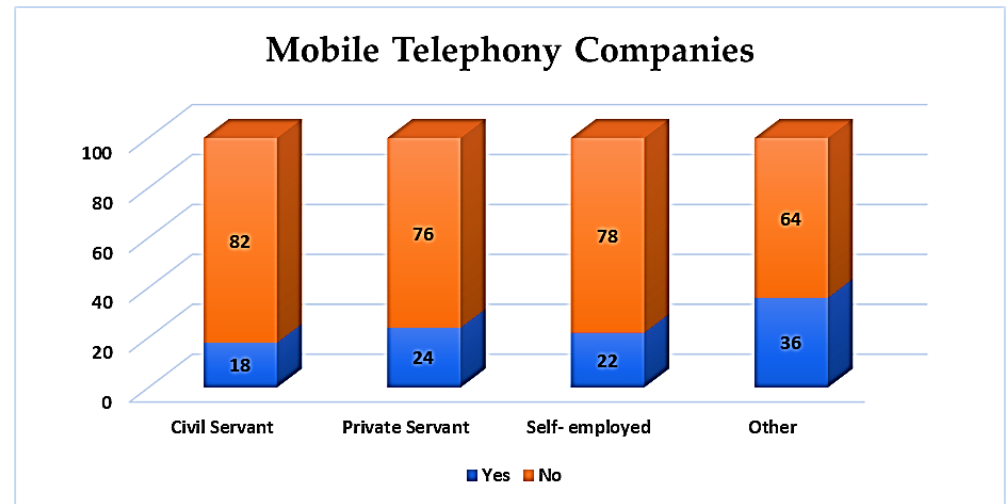
Figure 22. Services with security and identity protection.